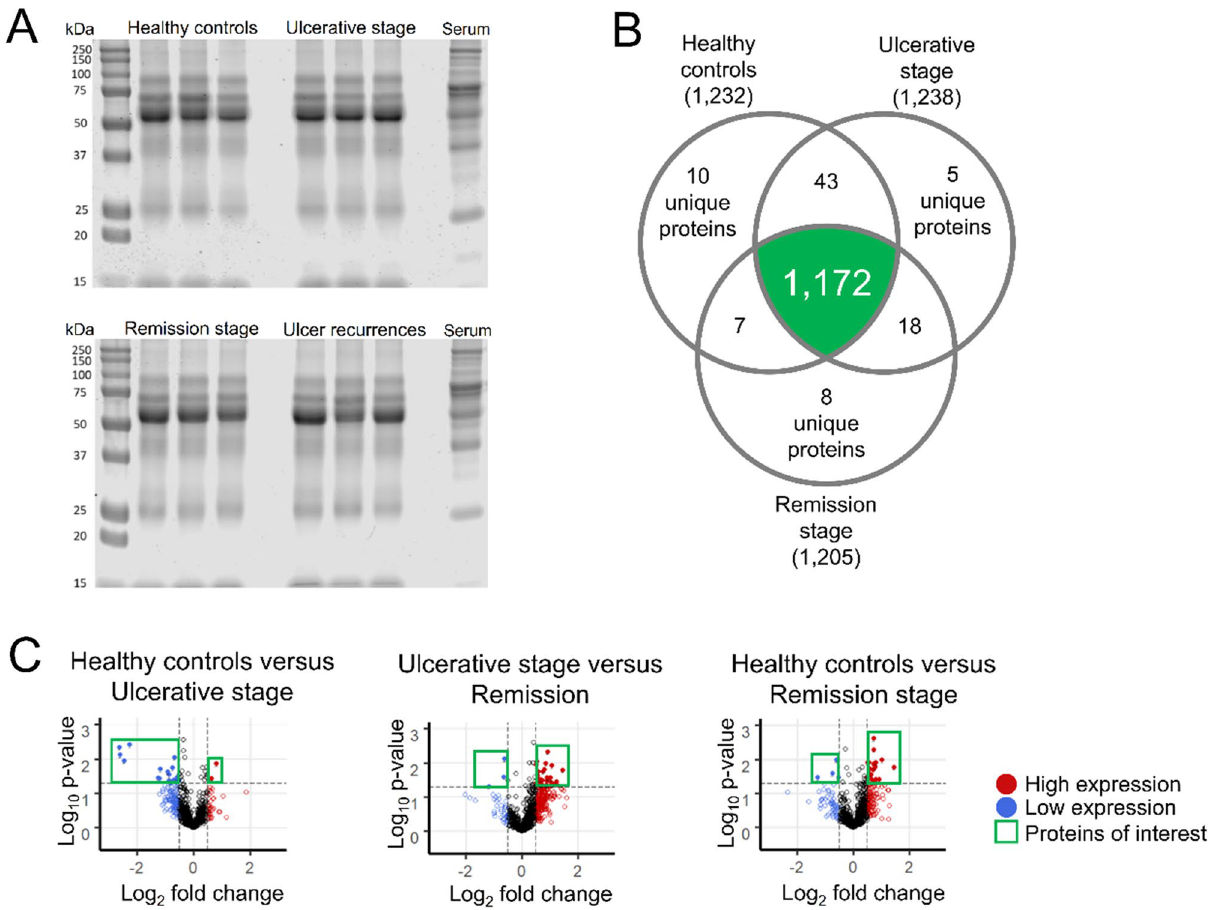
Figure 2. Salivary proteome. ( A ) We assessed samples integrity by SDS-PAGE gel electrophoresis (20 μg/lane protein concentration). ( B ) Venn diagram shows that most of the salivary proteins identified were proteins in common. ( C ) Volcano graphs show the windows considered in the analysis, constructed considering statistical significance and fold change. Proteins up- and down- regulated are enclosed by a green square. The fold change limits were − 0.5 and 0.5. The established p value was